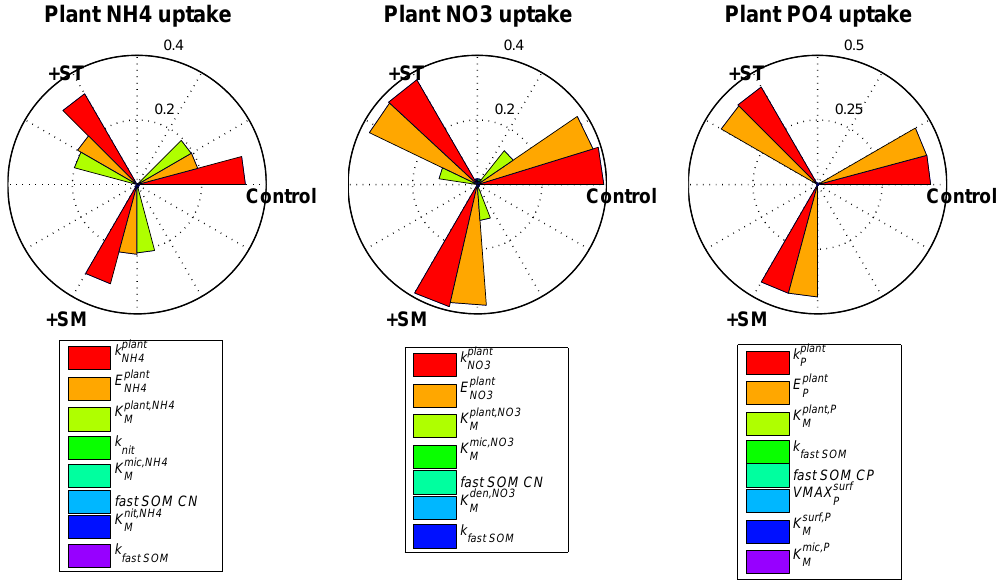
Figure 3. Model sensitivity analysis with SOBOL sampling. For each metric, three scenarios are shown: baseline (Control), elevated soil temperature by 5 ◦ C ( + T s ) , and elevated soil moisture by 50% ( + θ) , respectively. The length of bar (plot in polar coordinate) is the sensitivity (unit-less) of model output with respect to model input variables. Our results showed that the plant nutrient uptake was mostly regulated by internal consumer–substrate uptake kinetics rather than the external environmental conditions (e.g., T s , θ) .